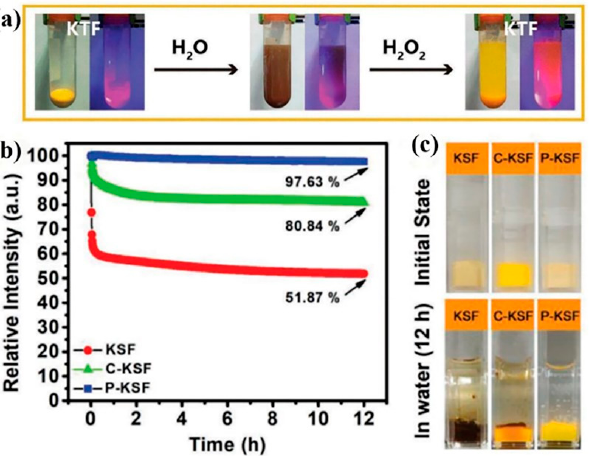
Figure 13. ( a ) Photos of KTF phosphors repaired with H 2 O 2 ; ( b ) the relative PL intensity of KSF, P- KSF, and C-KSF soaked in water for different times; ( c ) comparison of KSF, P-KSF, and C-KSF before and after soaking in water for 12 h. (Reprinted from Ref [51]. Copyright from John Wiley and Sons Ltd., 2018).